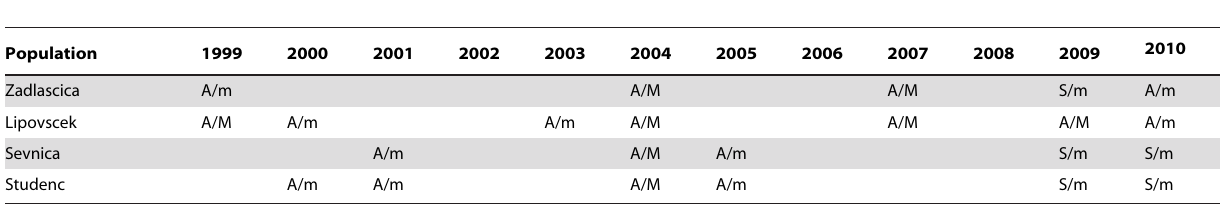
Table 1. Occurrence and intensity of flood events in the study area in the period 1999–2010, showing medium floods (m, 10 to 20- year recurrence interval) and major floods (M, 50 to 100-year recurrence